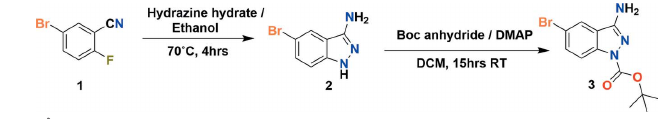
Figure 4 Synthesis scheme for the title compound.